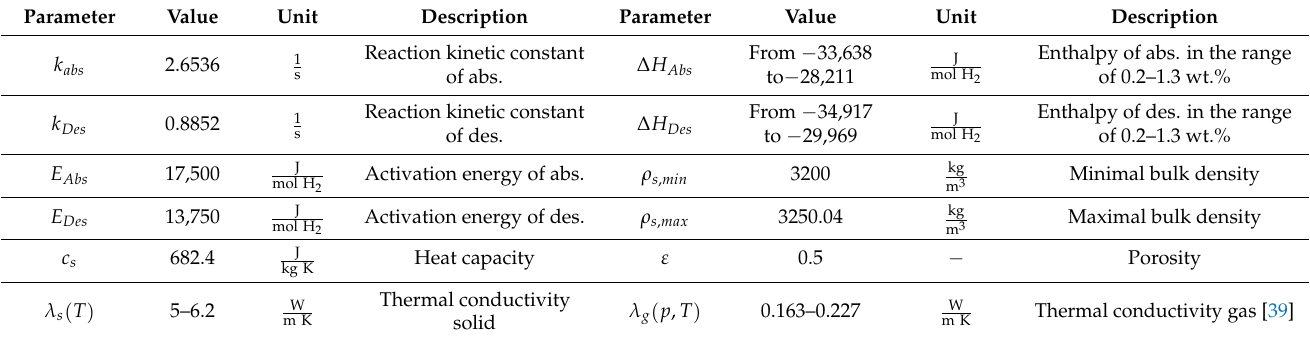
Table 4. Material, kinetic, and thermal parameters for the MH-system